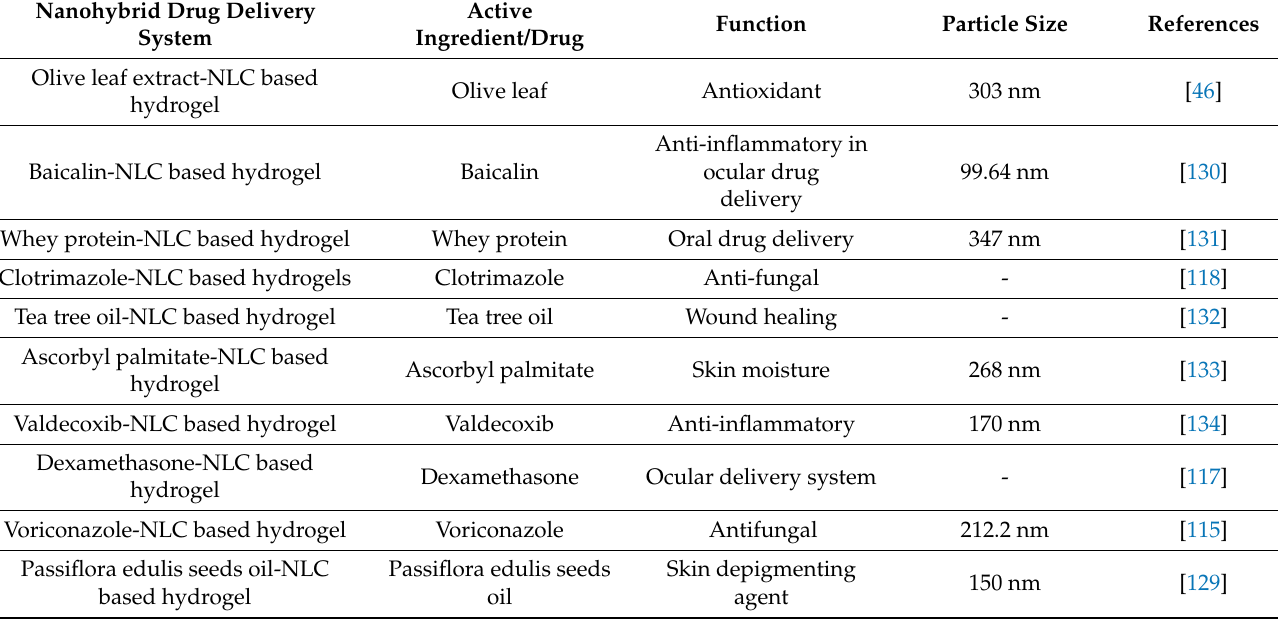
Table 3. Summary of recent nanohybrid system a function in drug